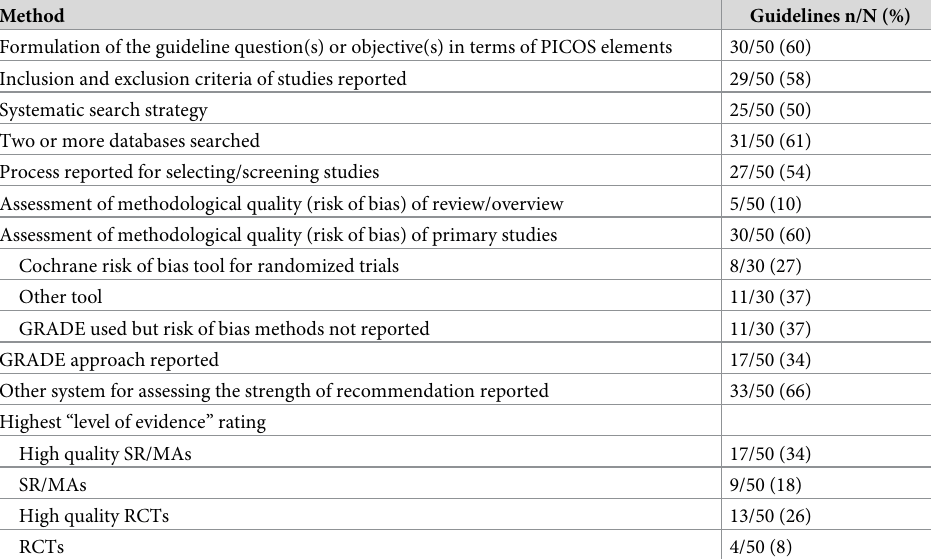
Table 4. Specific methods used for evidence synthesis in